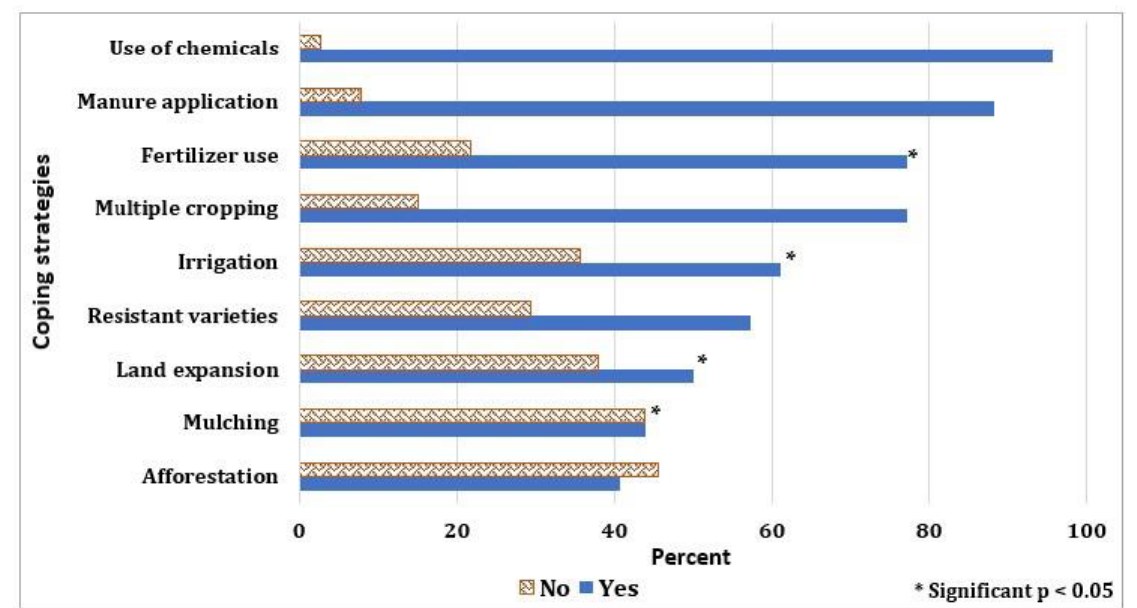
Figure 7. The various identified coping strategies adopted by farmers. Where (*) represents the significance of the variables at a 95% confidence level, and the type of crop grown is used as the determining factor for variation in adoption/response.